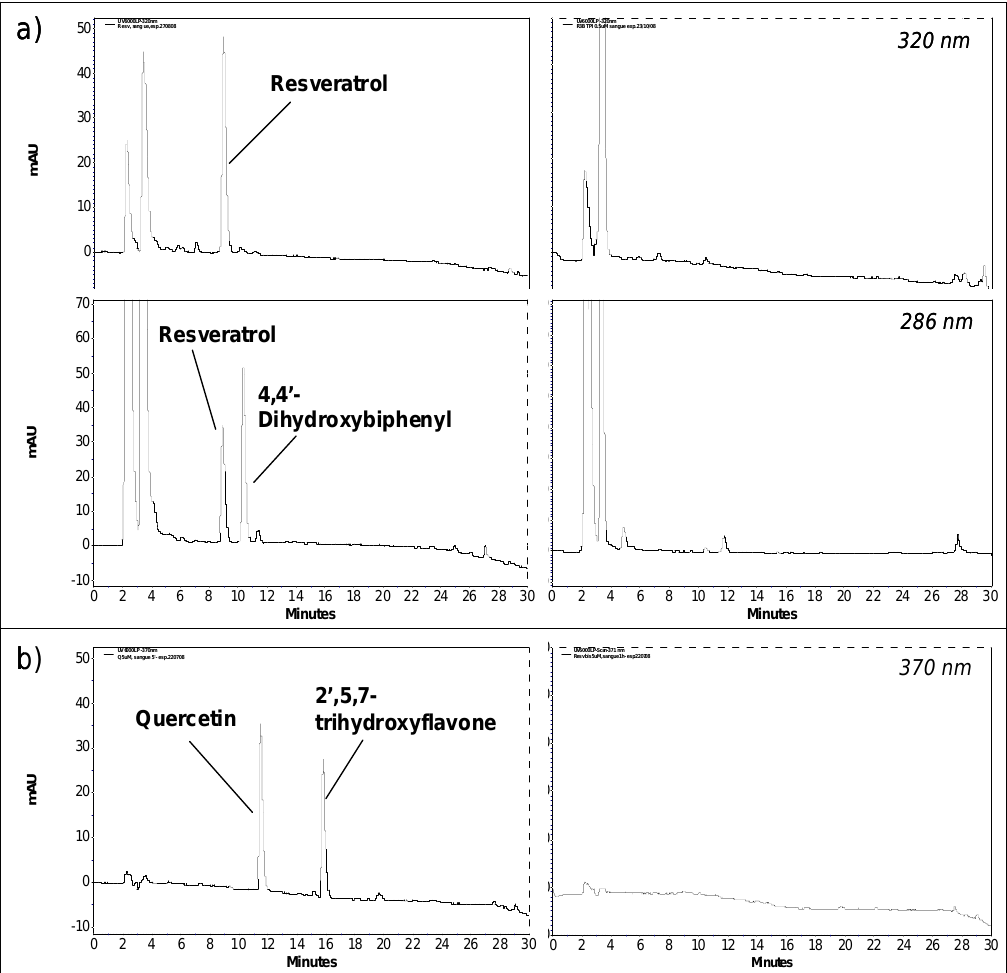
Figure 2. HPLC chromatograms of treated blood samples spiked with (a) 5 μ M resveratrol (recorded both at 286 and 320 nm) and (b) 5 μ M quercetin (recorded at 370 nm). Panels at right show the HPLC chromatogram (at the same wavelength) of a treated blood sample without any